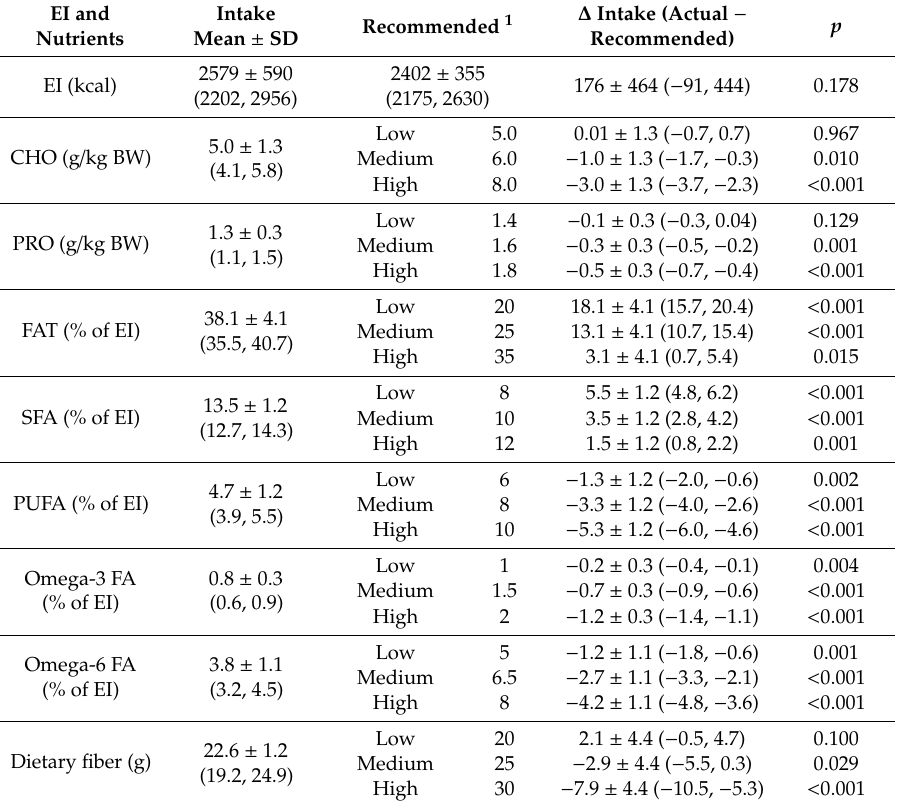
Table 3. Dietary intake of deaf